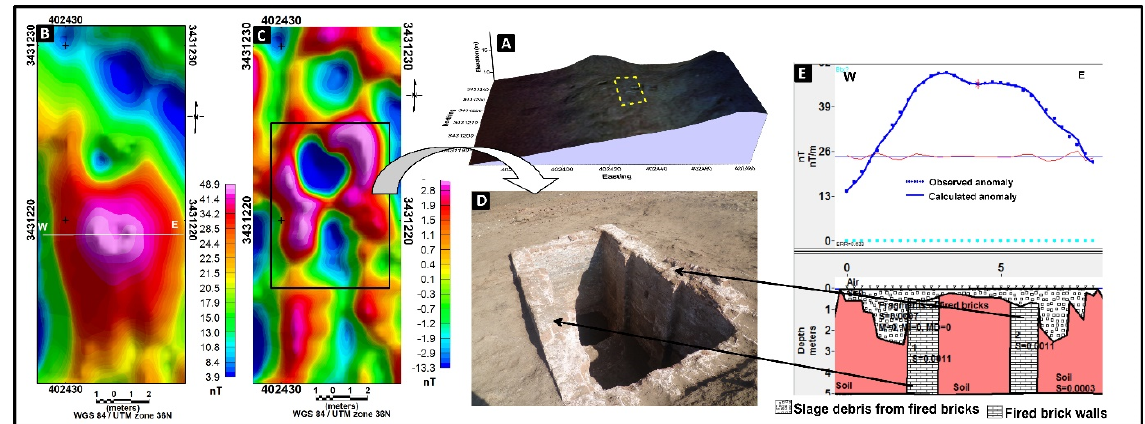
Figure 14. Magnetic results at the area around Spot D: (A) 3D geometry of the actual location of the area covered by the magnetic survey; (B) RTP magnetic map; the solid white line indicates the magnetic profile to be modeled; (C) high-pass filtered map using a cutoff wavenumber of 180 Radians/m; (D) a nearby excavated water tank; and (E) 2.5D modeling.